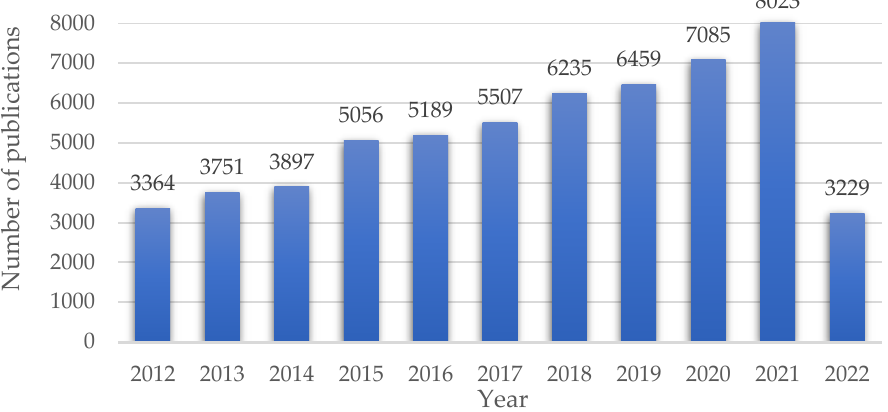
Figure 1. Number of publications concerning ‘‘photosensitizer” subjects since 2012. Adapted from ISI Web of Science, dated 12 July 2022.